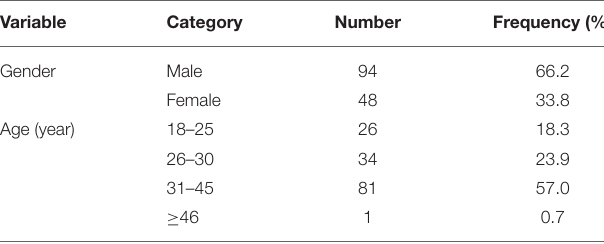
TABLE 1 | General information of the subjects ( n =